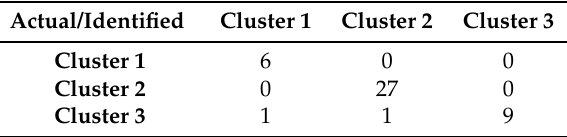
Table 1. Confusion matrix of ANFIS-based DS